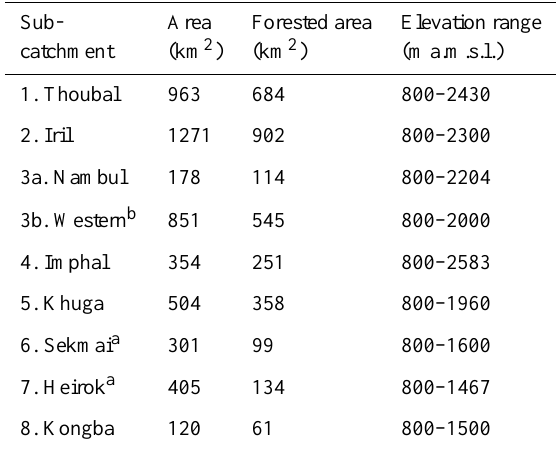
Table 1. Sub-catchments of Loktak Lake. Sub- Area Forested area Elevation